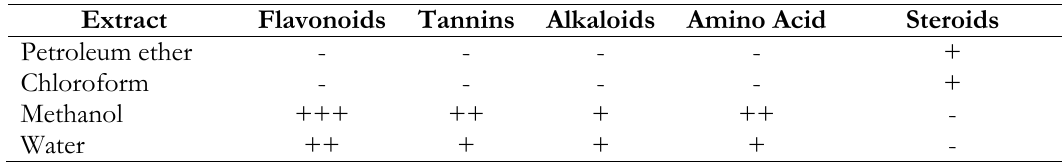
Table I. Result of preliminary phytochemical screening.